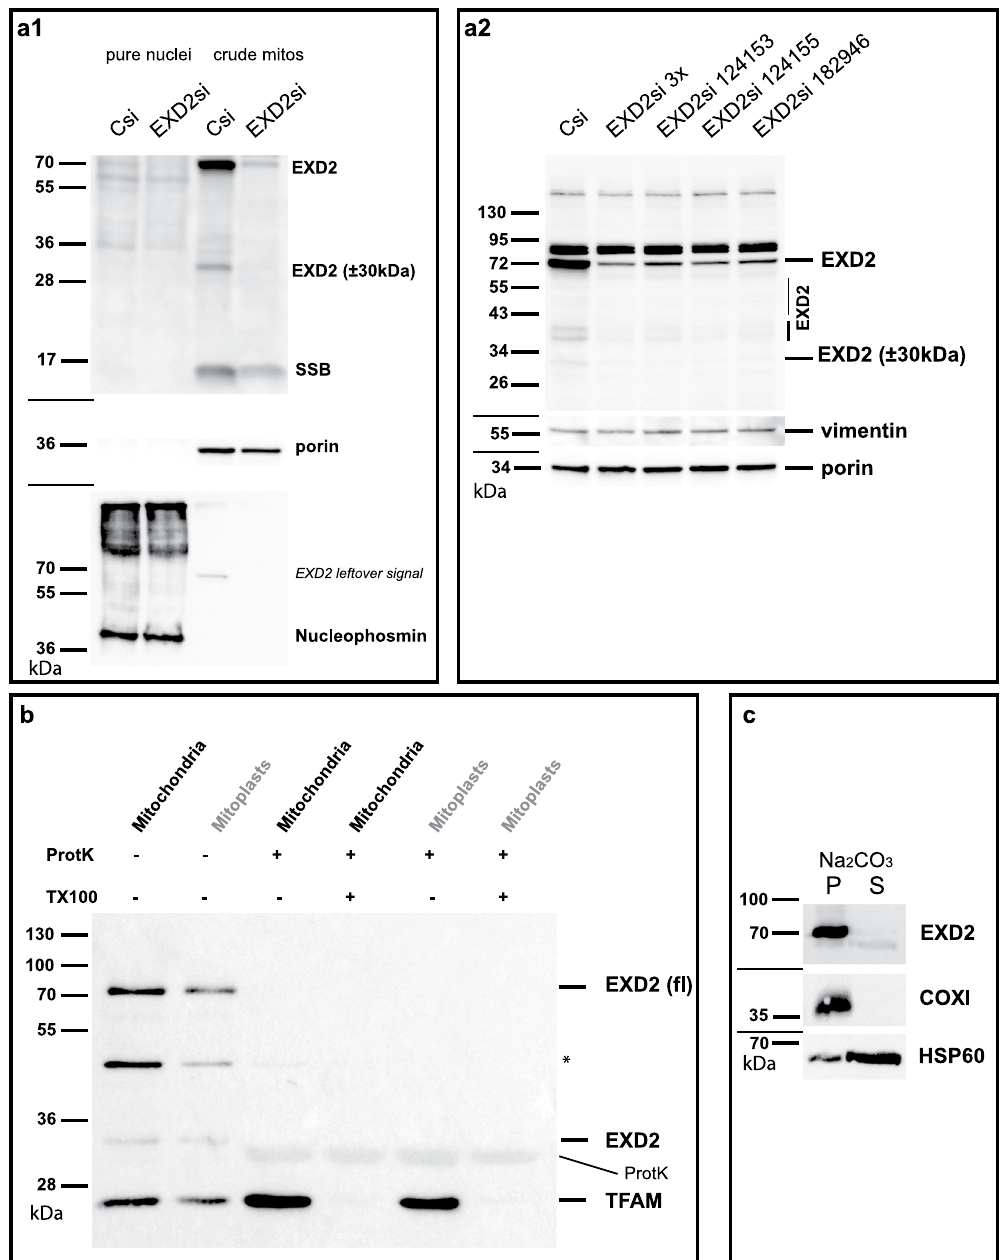
Figure 1. EXD2 is a mitochondrial outer-membrane associated protein. U2OS cell crude mitochondria isolated by differential centrifugation and pure nuclei isolated on iodixanol gradients were tested for EXD2 abundance in control siRNA and EXD2 siRNA treated cells (panel a1). Results show that the vast majority of EXD2, similar to mitochondrial marker proteins mtSSB and porin are found in the mitochondrial fraction and not in the nuclear fraction, in which the nuclear marker nucleophosmin is identified. SiRNA treatment confirms the identity of the full length (fl) ~70 kDa EXD2 protein and several lower abundant species of 30 kDa and higher molecular weight. Knockdown with either the combined pool of three commercial siRNAs or each individual siRNA show similar knockdown efficiencies in total cell lysates of U2OS cells on Western blots (panel a2). At the same time, several lower molecular weight EXD2 species are also identified and all appear to be equally sensitive to each individual siRNA suggesting they might be breakdown or processed EXD2 forms. Protease protection demonstrates mitochondrial EXD2 is mostly found in the mitochondrial outer-membrane (panel b). Mitochondria and digitonin-derived mitoplasts from HEK293 cells were treated either with Proteinase K (ProtK) alone or with ProtK and Triton-X100 (TX100) to lyse the inner and outer membrane. Results show that whereas TFAM, an mtDNA associated protein, is protected from ProtK in the absence of TX100, EXD2 is not, suggesting and outer-membrane localization. * Indicates a remnant signal from the probing with an antibody against a different mitochondrial candidate protein not relevant for this paper. A Na 2 CO 3 extract of